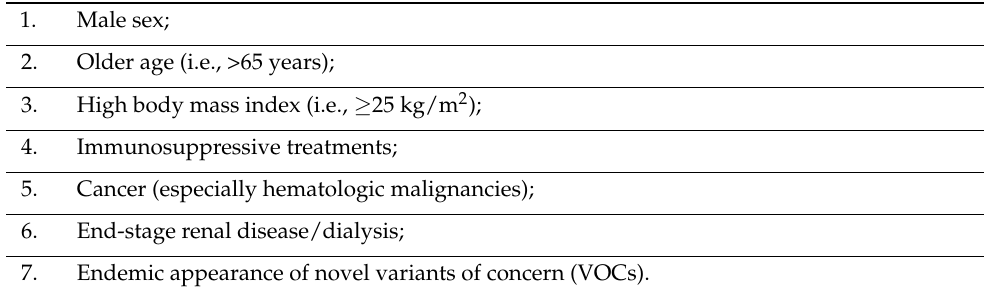
Table 2. Demographical and clinical factors associated with a lower COVID-19 vaccine immune